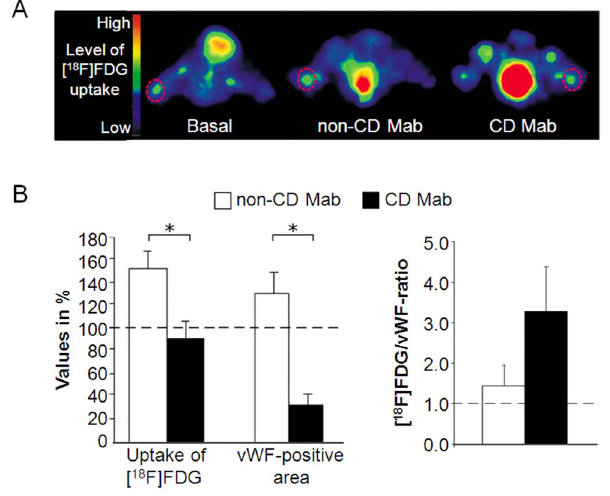
Figure 5. Vessel functionality studied by positron emission tomography (PET). (A) 2-[ 18 F]-fluoro-2-deoxy-D-glucose ([ 18 F]FDG) PET scans of mice implanted with matrigel (basal) or supplemented with celiac disease-specific monoclonal autoantibodies (CD Mab) or control antibodies (non-CD Mab). Each mouse received three matrigel implants (basal, CD Mab or non-CD Mab), each injected subcutaneously into separate limb as highlighted by circles in the scan. The magnitude of [ 18 F]FDG uptake is defined in different colors. (n=3) (B) The uptake of [ 18 F]FDG in the implants was analyzed from the PET images and the area occupied by vessels was determined by von Willebrand factor (vWF)-antibody staining (left panel). The ratio of [ 18 F]FDG uptake and vascular area was calculated (right panel). Bars represent average value as percentage + SEM. All data was normalized to the basal group (dotted line). * represents P # 0.05 statistical